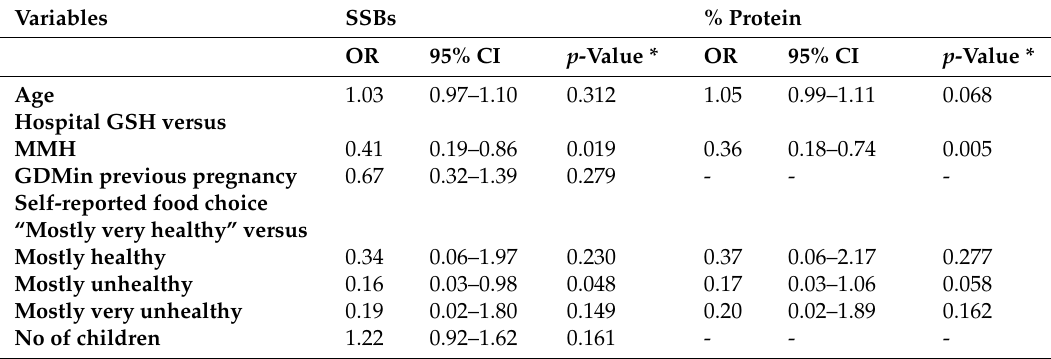
Table 7. Multivariate logistic regression analyses between sociodemographic factors and the proportion of participants consuming the recommended intake of SSBs (0 mL) and a Protein intake ≤ 15% of TE. Variables SSBs % Protein OR 95% CI p -Value *